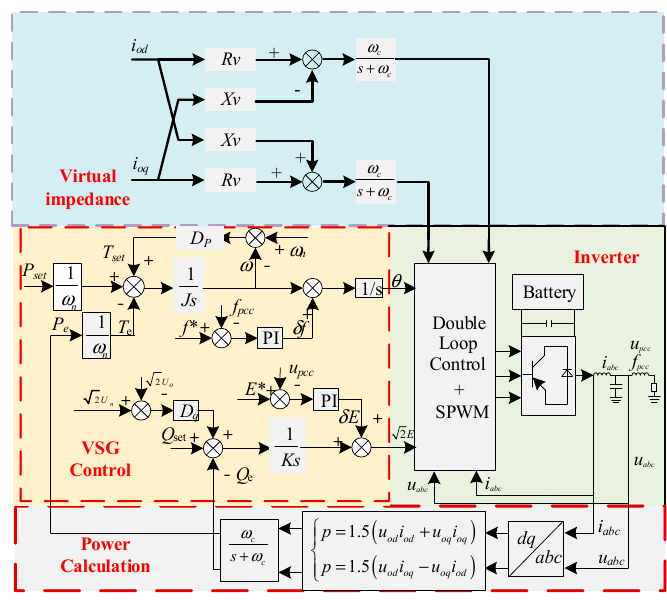
Figure 1. Virtual synchronous generator control loops.